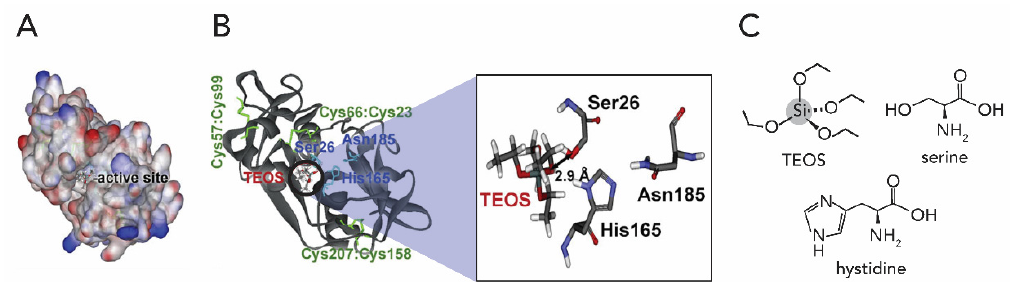
Figure 9. Model of silicatein-a from S. domuncula . ( A ) 3D model of the electrostatic charge distribution of silicatein-a (red: positive charges; blue: negative charges; white: hydrophobic areas). ( B ) The authors have co-crystallized tetraethylorthosilicate (TEOS) with silicatein, which as the crystal structure reveals is indeed found in the active site. Detail shows the steric proximity of the amino acids of the catalytic center to the TEOS molecule. ( C ) TEOS, histidine and serine molecules. Adapted from [30] with permission from Springer Nature.